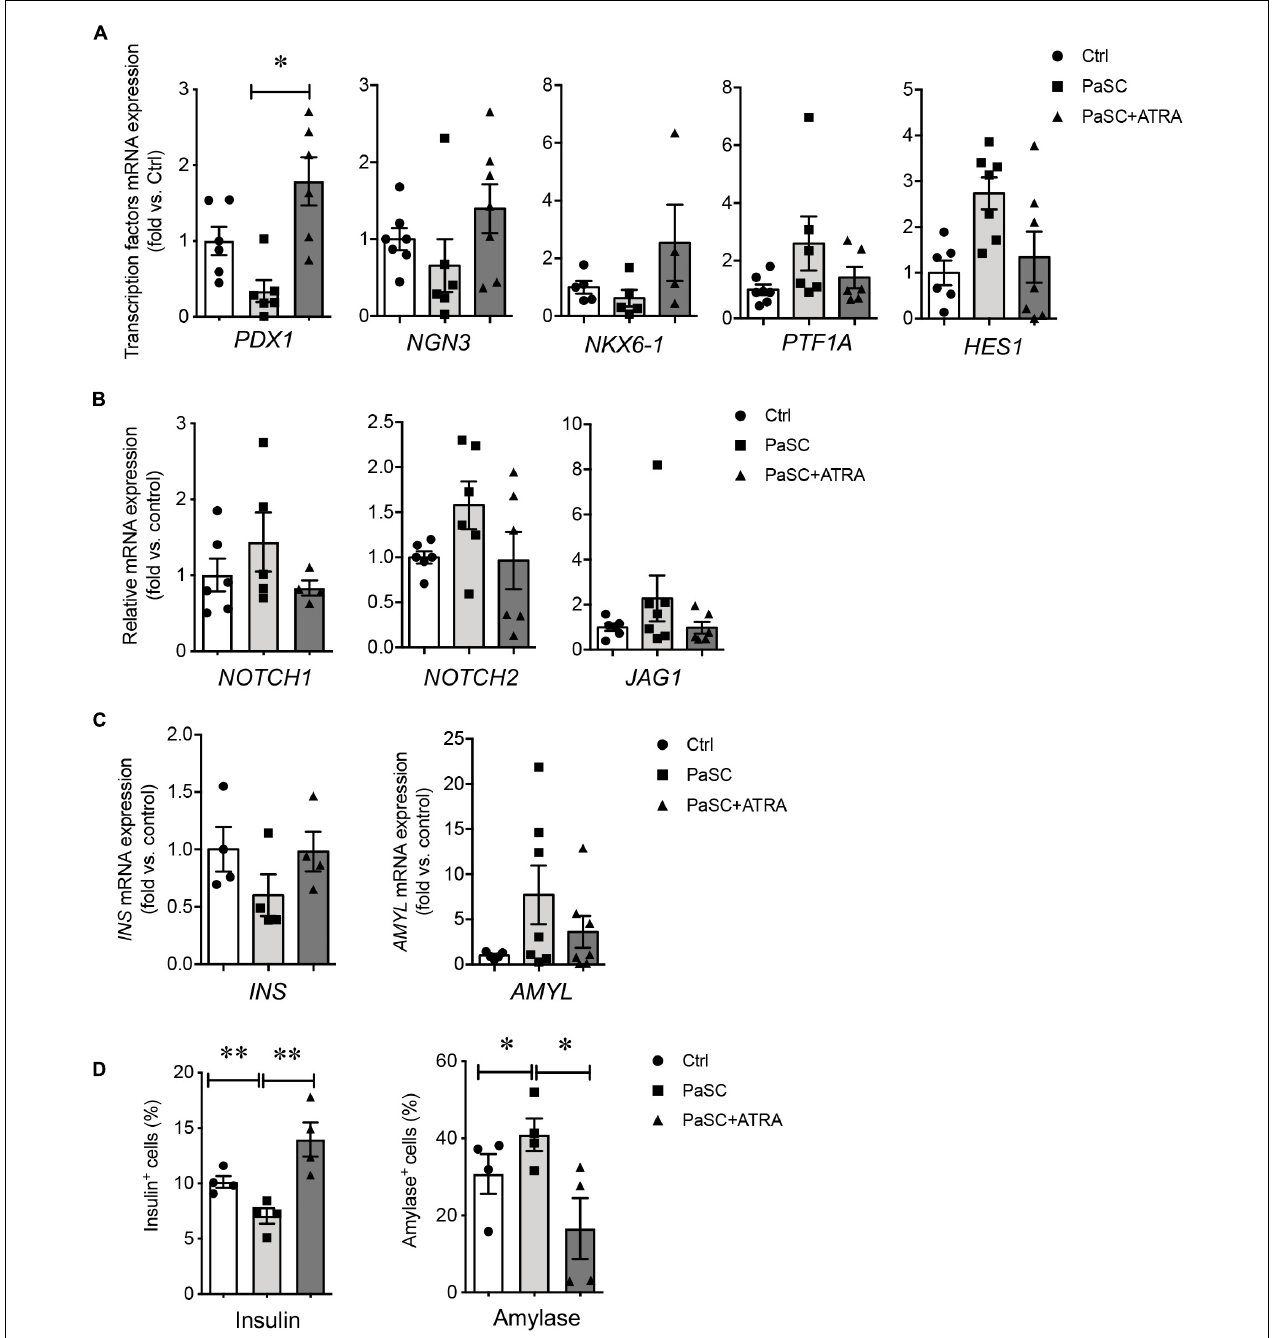
FIGURE 6 | PaSCs enhance exocrine cell differentiation in hIECCs during an indirect co-culture using a Millicell R (cid:13) Inserts culture system. qRT-PCR analysis of (A) transcription factor, (B) Notch signal and (C) pancreatic gene expressions, and (D) the percentage of insulin + and amylase + cells in hIECCs during an indirect co-culture with PaSCs for 48 h. Closed circles, control (with no PaSC); closed squares, PaSC; closed triangle, PaSC + ATRA. Data are expressed as mean ± SEM ( n = 4–6 experiments/treatment group). ∗ p < 0.05, ∗∗ p < 0.01; analyzed using one-way ANOVA with Tukey’s post hoc test.